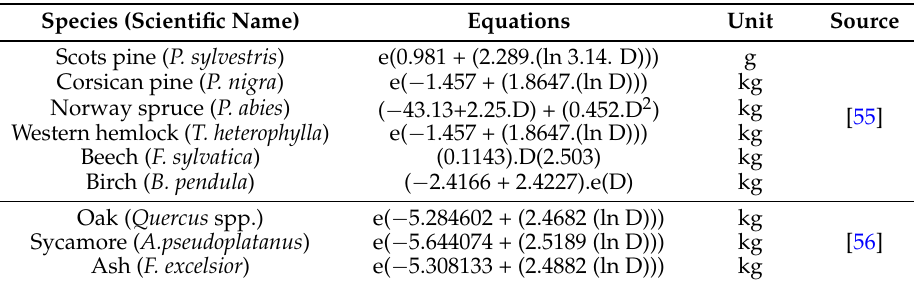
Table 2. Allometric equations used to estimate tree above-ground